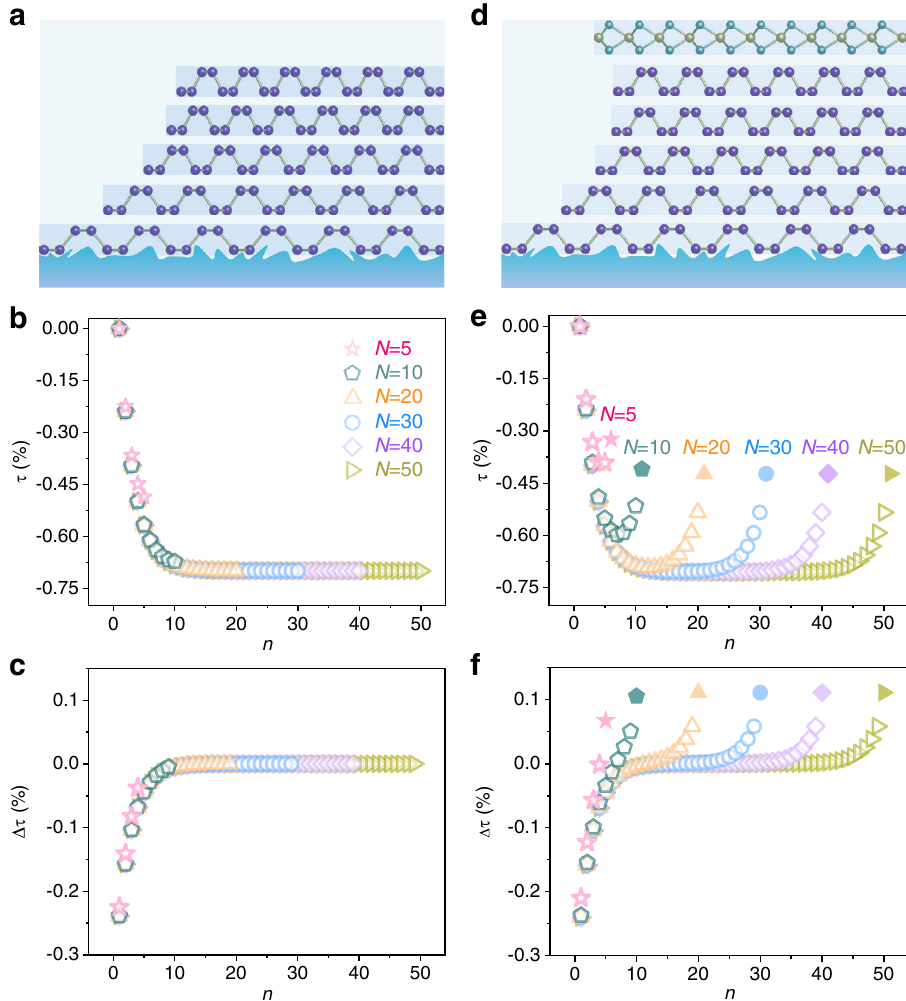
Fig. 5 Resolving STD and ISTD of individual layer in phosphorene/SiO 2 and WSe 2 /phosphorene/SiO 2 systems. a Schematic diagram of 5-layer phosphorene/SiO 2 under thermomechanical deformation at low temperature. b , c Theoretically calculated layer-dependent τ ( b ) and Δ τ ( c ) in phosphorene/SiO 2 at representative layer numbers N = 5, 10, 20, 30, 40 and 50. d Schematic diagram of WSe 2 /5-layer phosphorene/SiO 2 at at low temperature. e , f Theoretically calculated layer-dependent τ ( e ) and Δ τ ( f ) in WSe 2 /phosphorene/SiO 2 at representative layer numbers N = 5, 10, 20, 30, 40, and 50. Here, the empty symbols denote values in phosphorene while the fi lled symbols denote values in WSe 2